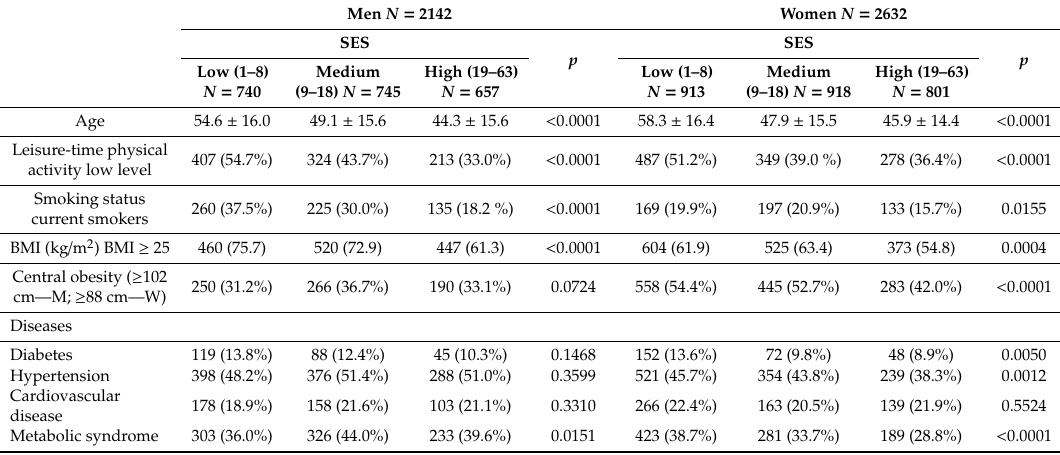
Table 2. General characteristics of the studied population ( N = 4774) according to their socioeconomic status (SES) score (adjusted for